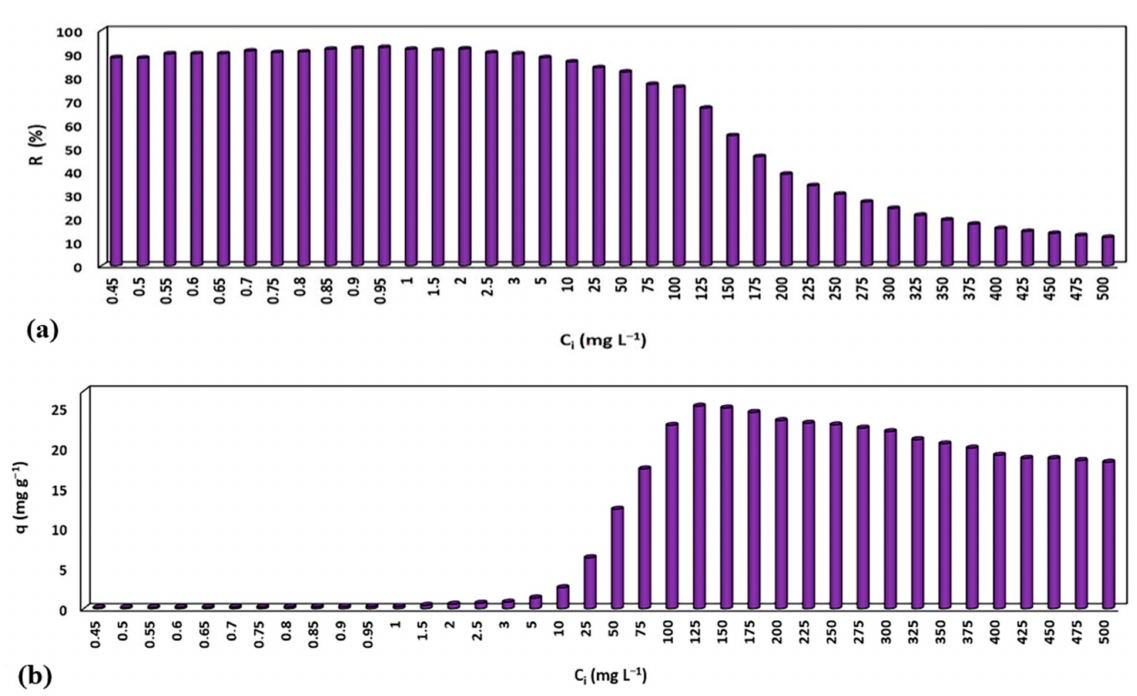
Figure 5. Effect of initial CV concentrations (0.45–500 mg L − 1 ) on the removal efficiency ( a ) and adsorption capacity ( b ) of MNP@PAAA-FA determined by UV-VIS spectroscopy at a spectral resolution of 1 nm and 591 nm wavelength.